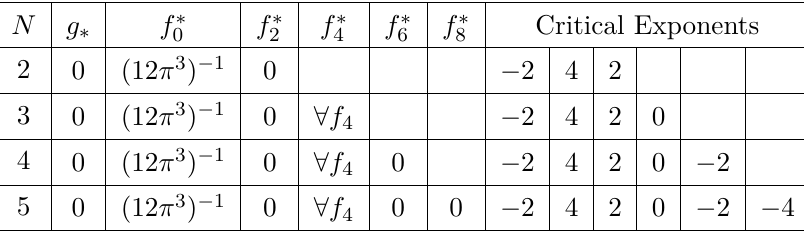
Table 2 . GFP line in D = 4 , for various values of N